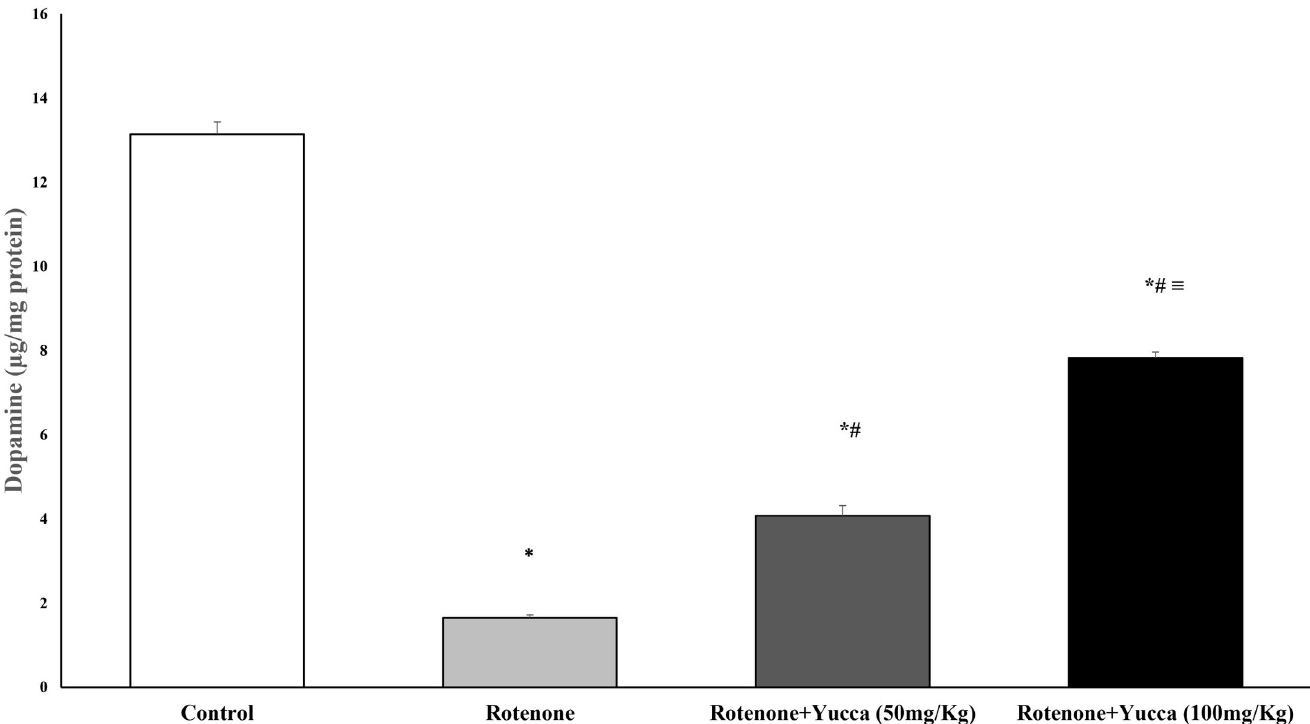
Fig 7. Effect of rotenone and its cotreatment with yucca extract on striatal Dopamine ( μ g/mg protein). Data are represented as the mean ± SEM of eight animals in each group. ( � ) Significantly differs ( P < 0.05) compared to control group; (#) significantly differs ( P < 0.05) compared to rotenone alone treated group; ( � ) significantly differs ( P < 0.05) compared to rotenone + yucca (50mg/kg) treated group.